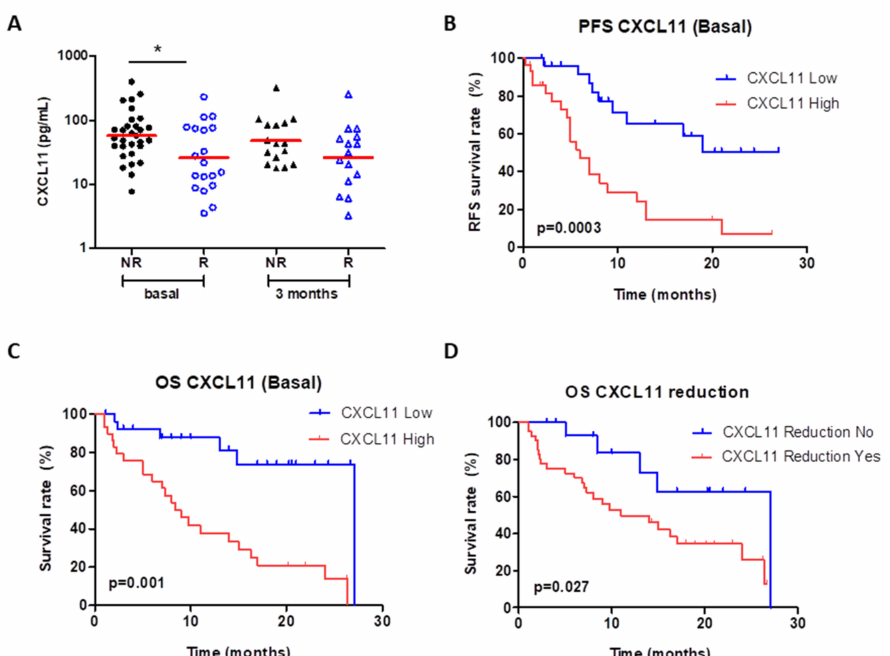
Figure 4. Blood levels of CXCL11 (ITAC). Higher basal levels are shown in non-responders (NR, n = 30, p < 0.05) than in responders (R, n = 19) with a similar trend 3 months after treatment (NR, n = 16; R, n = 15) ( A ). Elevated levels of this chemokine are significantly associated with decreased PFS ( p = 0.003, ( B )) and OS ( p = 0.001, ( C )). Reduction in CXCL11 over the course of drug administration is also related to worse OS ( p = 0.027, ( D )). The logrank test was used for the